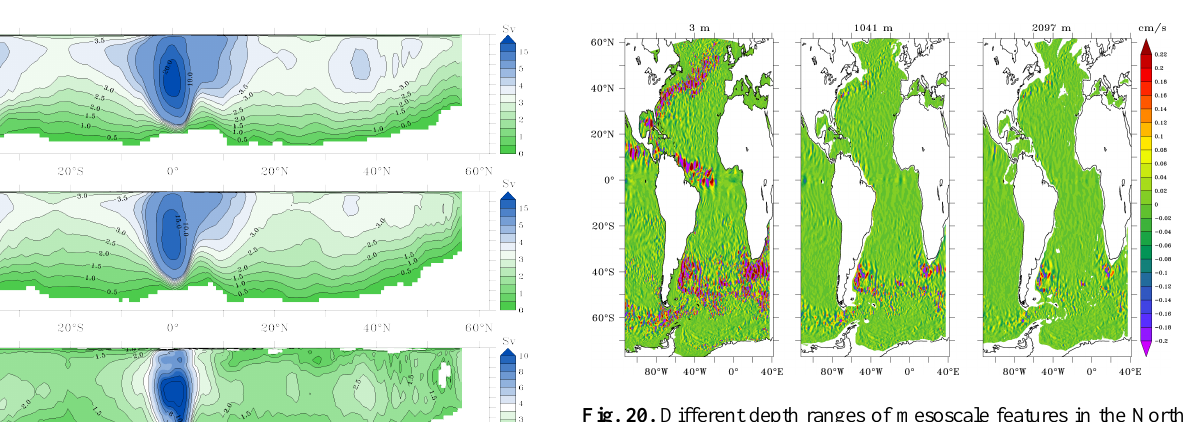
Figure 19: Standard deviations of the Atlantic MOC in the 1 / 4 ◦ (top) and 1 ◦ versions of the model. The standard deviation of the additional variability occurring in the 1 / 4 ◦ model is shown in the bottom panel. √ It is calculated according to variance B 025 − variance B 100 .